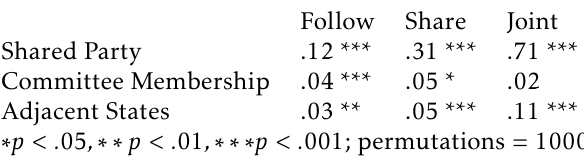
Table 3. Correlation between Network Centrality and Year Entered Senate for all senators